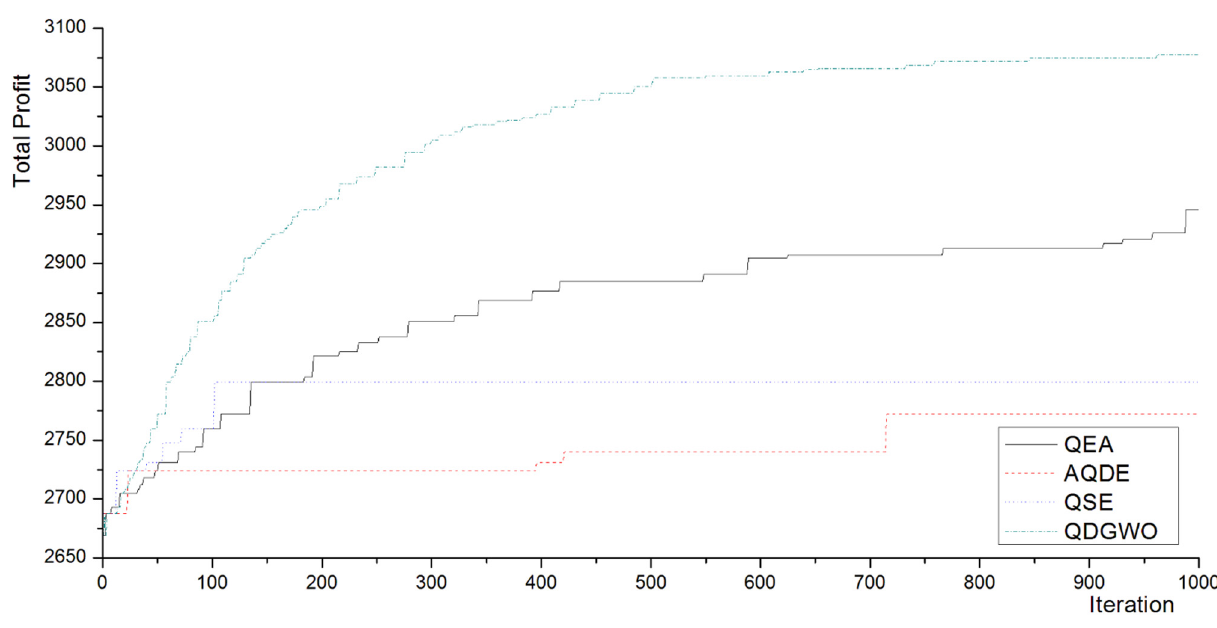
Figure 5. Best profits for the 0-1 knapsack problems (500 items in Experiment 1).